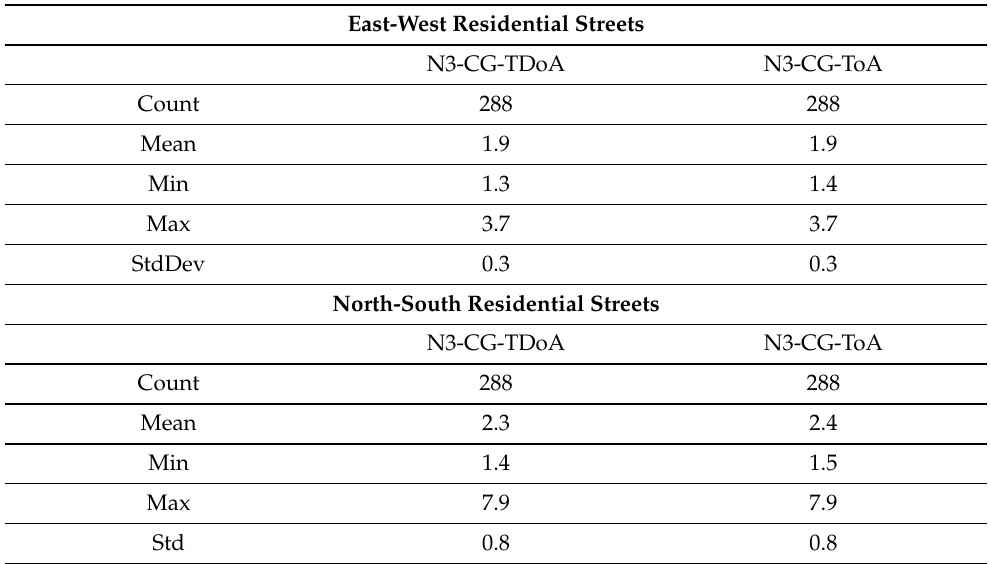
Table 11. Residential streets: statistical analysis of PDOP for GNSS and three staggered 5G stations (N3) in TDoA (CG-TDoA) and ToA (CG-ToA)